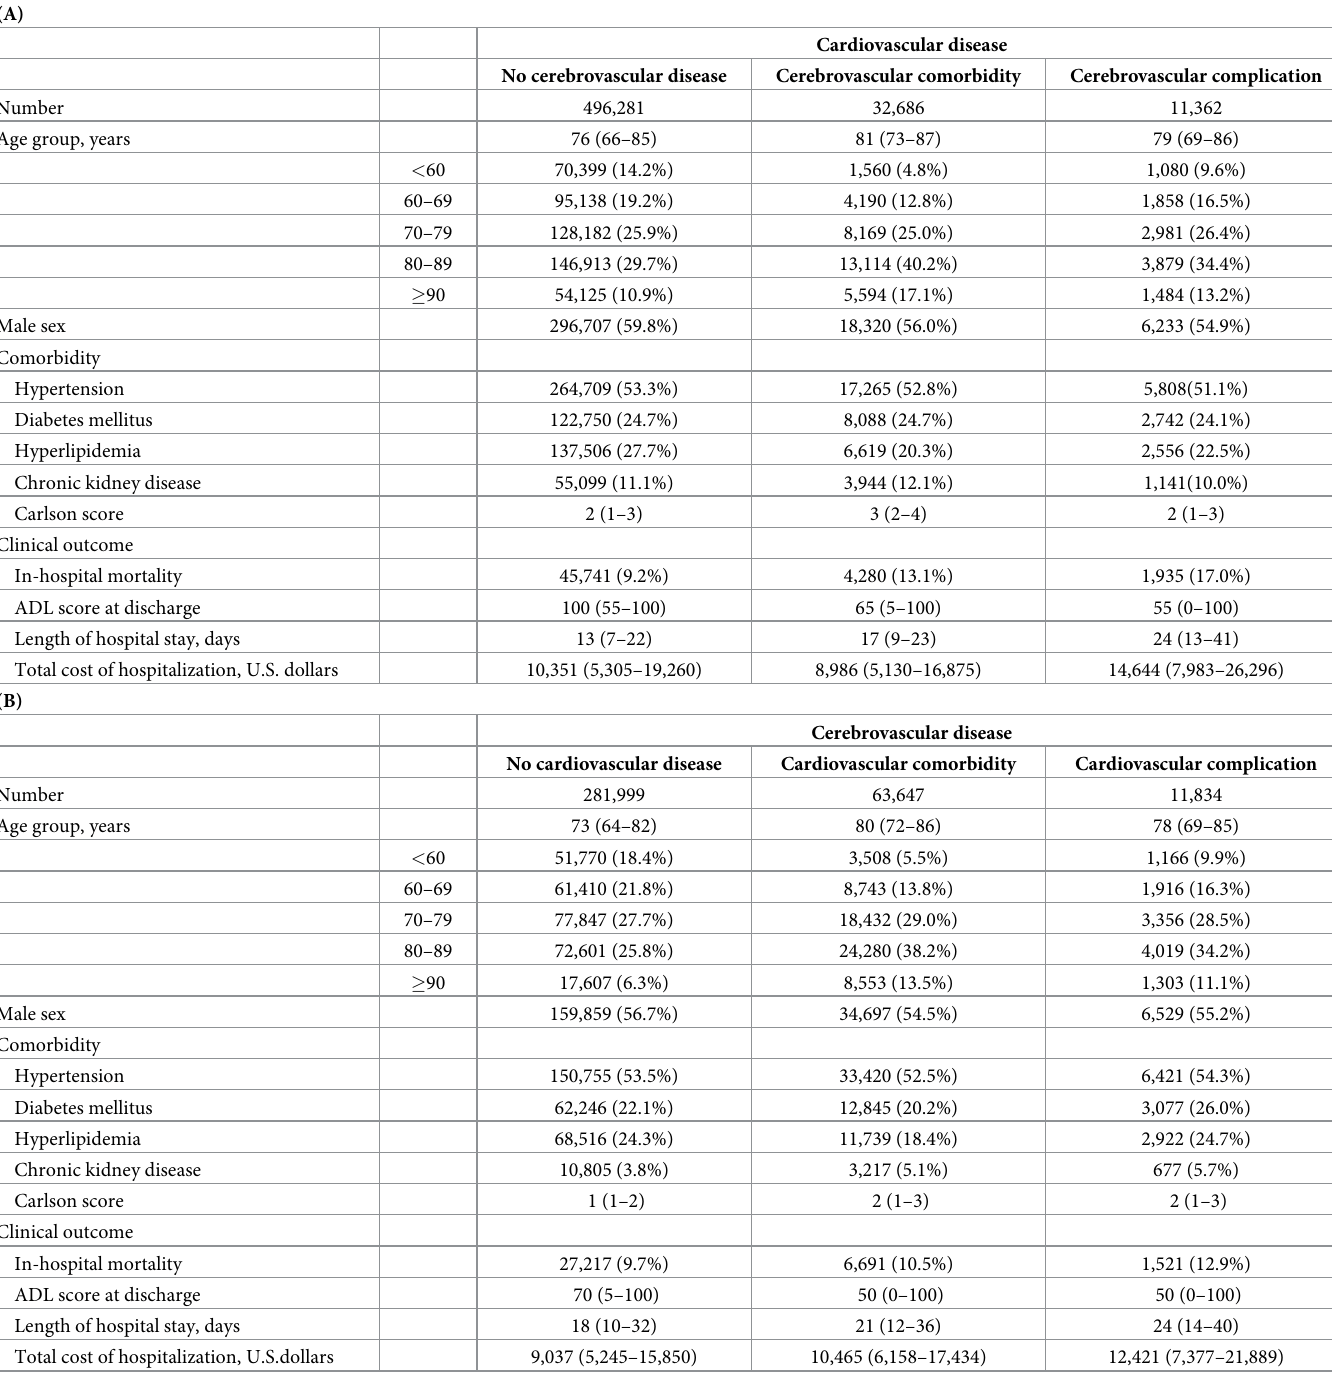
Table 1. Patient characteristics and